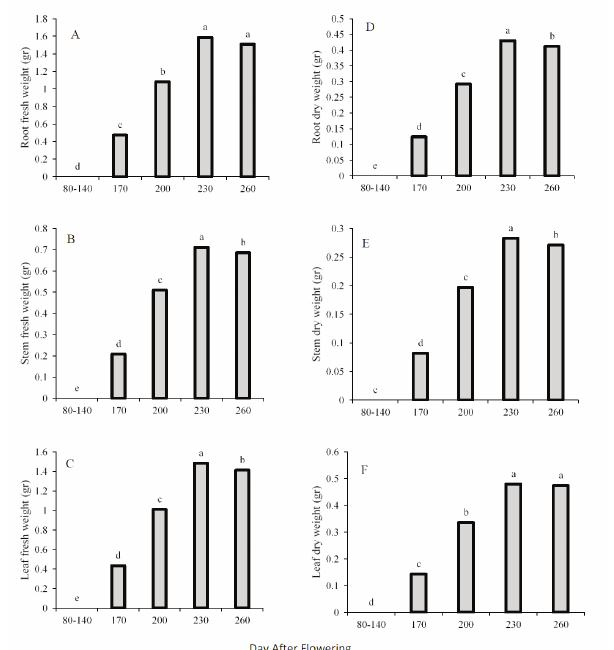
Fig. 5 ­ Effect of harvest time on seedlings root, stem and leaf fresh weight (A­C) and dry weight (D­F) of sour orange under in vitro conditions. Means with the same letter are not significantly different at 1% probability using LSD.